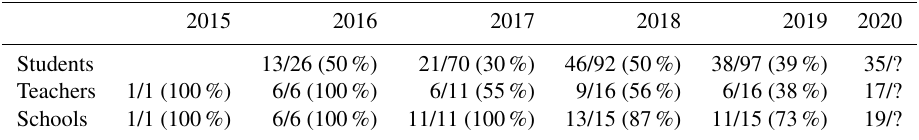
Table 3. Response rates to questionnaires at PRiSE student